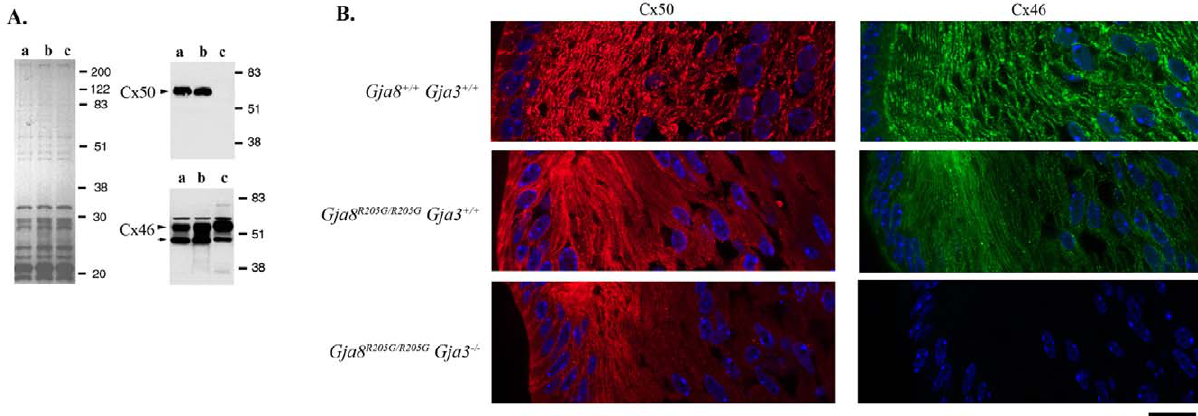
Figure 3. Biochemical and immunological characterization of Cx50 and Cx46 proteins. ( A ) Total lens homogenates, prepared from Gja8 R205G/R205G (a), Gja8 R205G/ 2 (b) and Gja8 2 / 2 (c) littermates at one week of age, were examined by a Coomassie-blue stained gel (left panel) and by western blot using an anti-Cx50 antibody and an anti-Cx46 antibody (right panels). Arrowheads indicate phosphorylated proteins while the arrow indicates non-phosphorylated proteins. Compared to Gja8 2 / 2 lenses, mutant Gja8 R205G/R205G lenses showed decreased phosphorylated Cx46 proteins. ( B ) Immunostaining results of lens frozen sections showed typical punctate signals of Cx50 (red) and Cx46 (green) connexin proteins in wild-type ( Gja8 + / + Gja3 + / + ) sample, but only diffuse tiny spots of Cx50 and Cx46 could be seen in Gja8 R205G homozygous mutant ( Gja8 R205G/R205G Gja3 + / + ) sample. Diffuse tiny spots of Cx50 were observed in Gja8 R205G Gja3 double mutant ( Gja8 R205G/R205G Gja3 2 / 2 ) sample. These lens samples were prepared from 1-week-old mice. Scale bar, 20 m m.